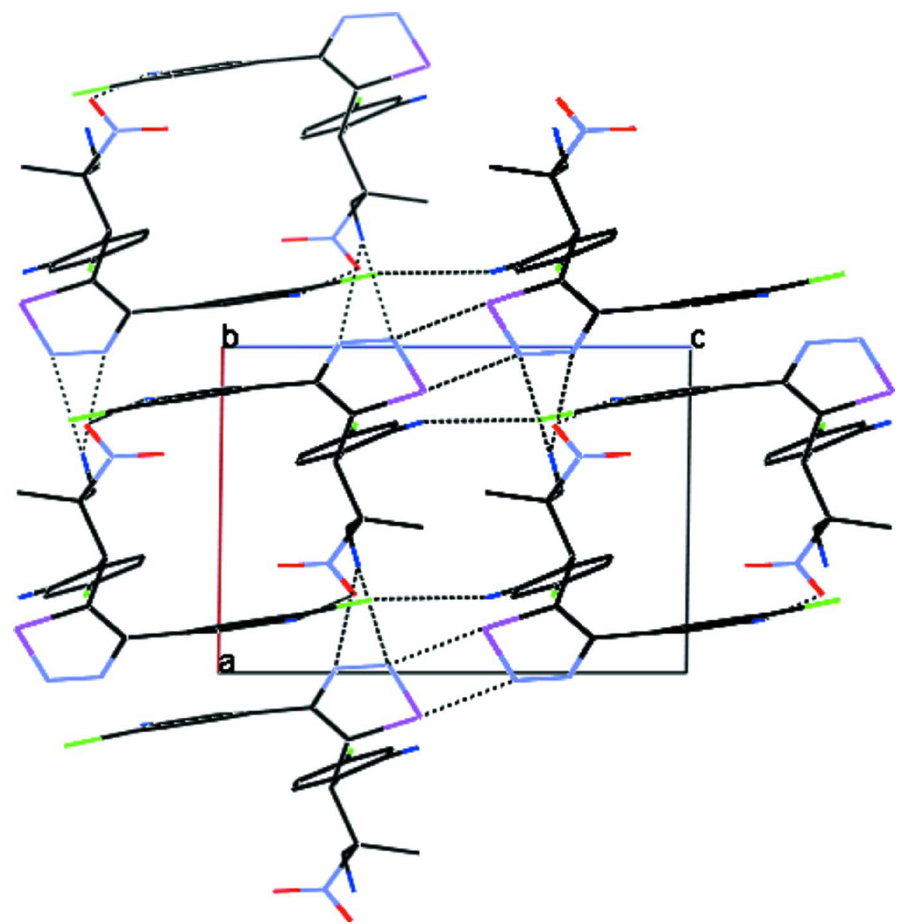
The packing of (I), viewed down the b axis. Hydrogen bonds are shown as dashed lines. H atoms not involved in hydrogen bonding have been